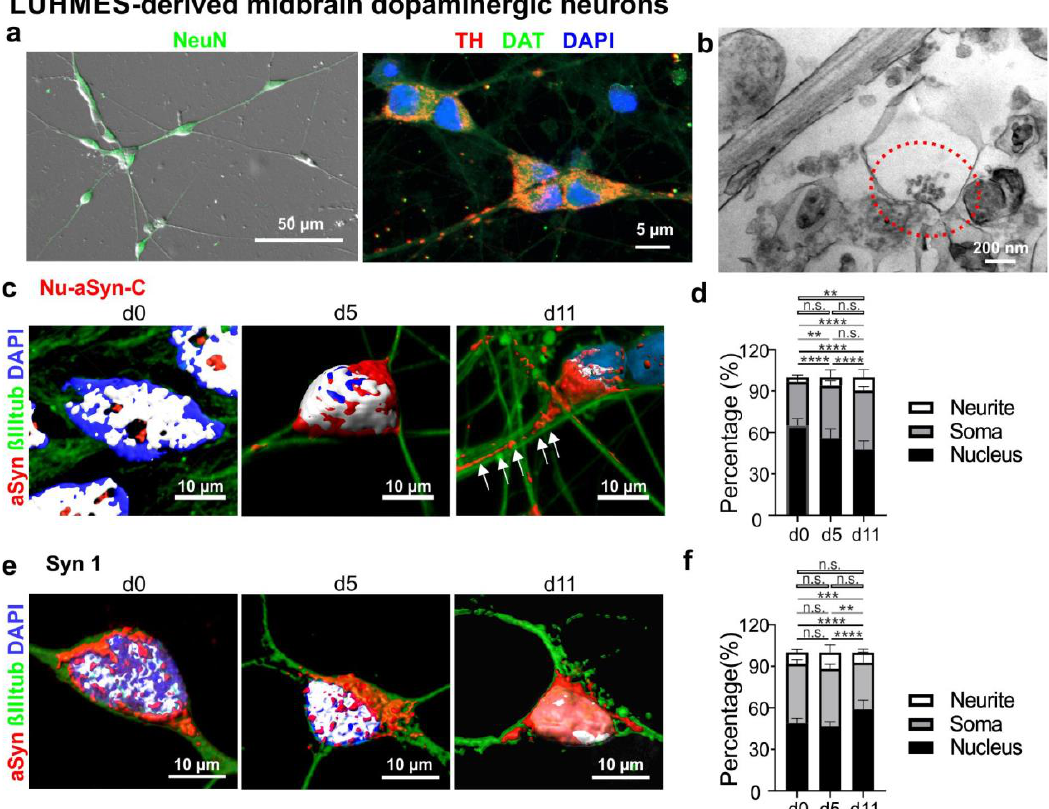
Figure 4. Characterization of mDANs differentiated from LUHMES cells. ( a ) Representative neurons differentiated for 5 days show the expression of the neuronal marker NeuN (left, green) and dopaminergic neuronal markers TH (red) and DAT (green). ( b ) Representative EM image with a synaptic site (red circle) in LUHMES cells differentiated for 35 days. ( c , e ) Representative 3D reconstructed fluorescence images of LUHMES cells at the proliferating stage (d0), and differentiated for 5 (d5) and 11 days (d11) labelled with either the Nu-aSyn-C ( c ) or Syn1 antibody ( e ), βIIItub and DAPI. ( d , f ) Quantification of aSyn distribution (in %) in the nucleus, soma, and neurites, labeled with either the Nu-aSyn-C ( d ) or Syn1 ( f ) antibody. In the 3D reconstructed images ( c , e ), nuclear localization of aSyn is depicted in white due to the special morphology of LUHMES cell bodies characterized by a close arrangement of the nucleus and the surrounding soma. The Nu-aSyn-C antibody detects a strong localization of aSyn in the nucleus of proliferating cells (d0). Upon differentiation (d5 – d11), aSyn signal intensity in the soma and neurites significantly increases. This shift of the aSyn signal revealed by the Nu-aSyn-C antibody is much less visible using the Syn1 antibody. For quantification ( d , f ), data represent the mean ± SD from 9 – 19 cells of each time point measured in three independent experiments. Statistics: Two-way ANOVA, Tukey’s multiple comparisons test , n.s.: not significant, ** p < 0.005, *** p < 0.0005, and **** p < 0.0001. Black lines: comparisons of nuclear signal intensity; grey lines: comparisons of soma signal intensity; white lines: comparisons of neurite signal intensity.